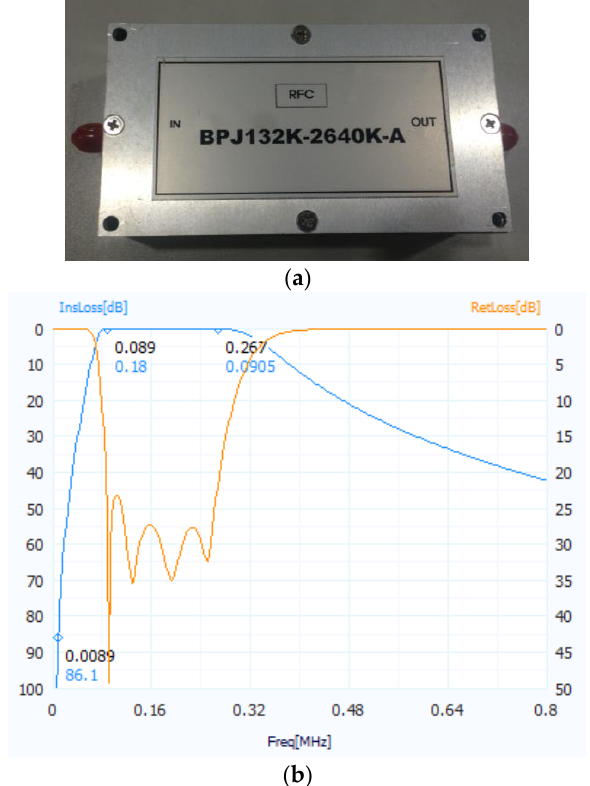
Figure 6. Bandpass filter ( a ) Image of real product ( b ) Filter response.